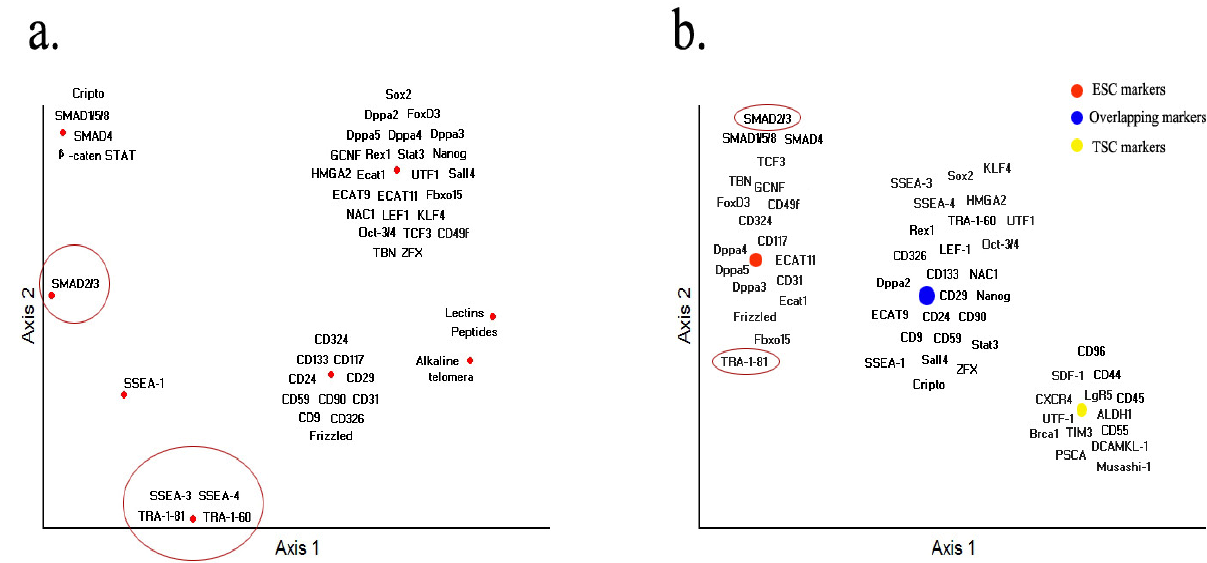
Figure 2. Non-metric multidimensional scaling (NMS) ordination. ( a ) The expression patterns of markers in ESC. To identify the expression profiles of markers in embryonic stem cells, similarity matrix was computed on the basis of presence/absence of such parameters as mouse embryonic stem cells, human stem cells, nuclear, cytoplasm, surface, enzymatic and out of cell. ( b ) The expression patterns of markers between ESC and TSC. Similarity matrix was computed merely based on the presence/absence. NMS was performed using Medium Autopilot and others as defaulted. Distance matrix was calculated based on